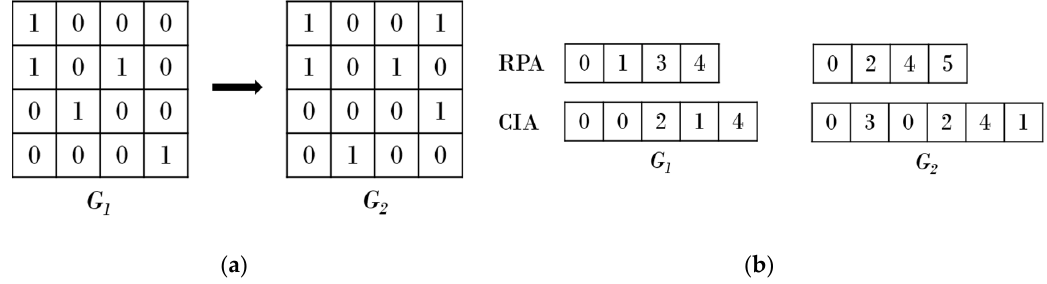
Figure 5. Compressed Sparse Row (CSR): ( a ) Sparse matrix representation for dynamic graphs; ( b ) Existing CSR representation.